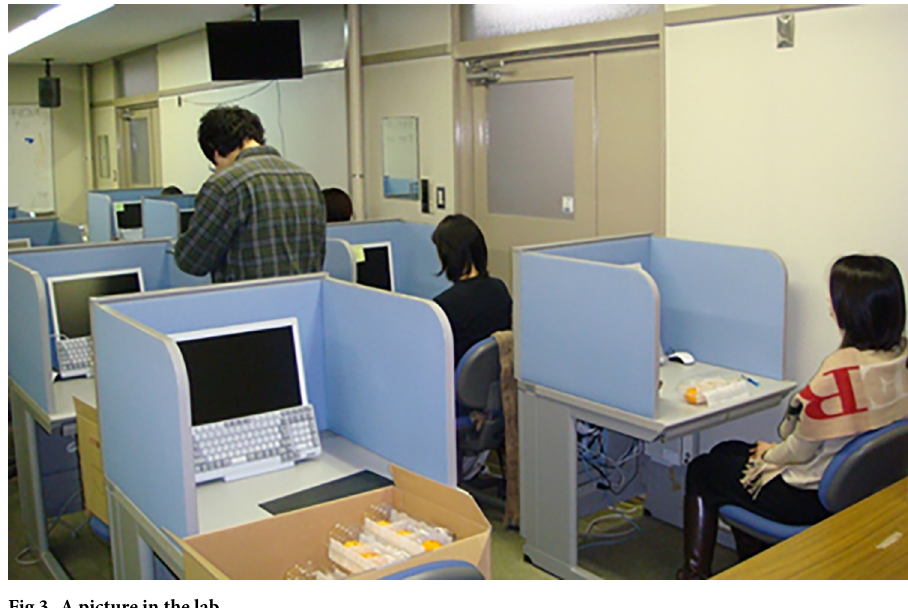
Fig 3. A picture in the